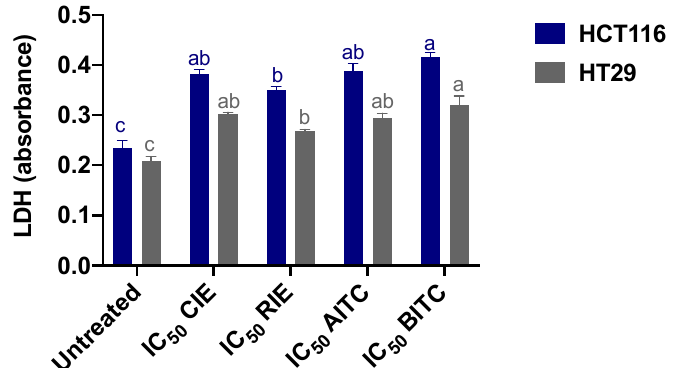
Figure 3. Lactate dehydrogenase (LDH) activity in HCT116 and HT29 treated with the half-inhibitory concentrations of cauliflower isothiocyanate (CIE) and radish isothiocyanate (RIE) extracts, allyl isothiocyanate (AITC), and benzyl isothiocyanate (BITC). The results are the mean ± SD of three independent experiments in triplicate. Different letters express significant differences ( p < 0.05) by the Tukey–Kramer test for each cell line between treatments. Untreated cells corresponded to MEM-only-treated cells.